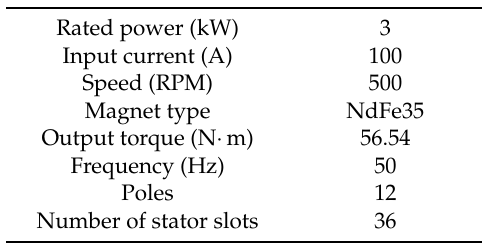
Table 1. The essential parameters of (CPM).